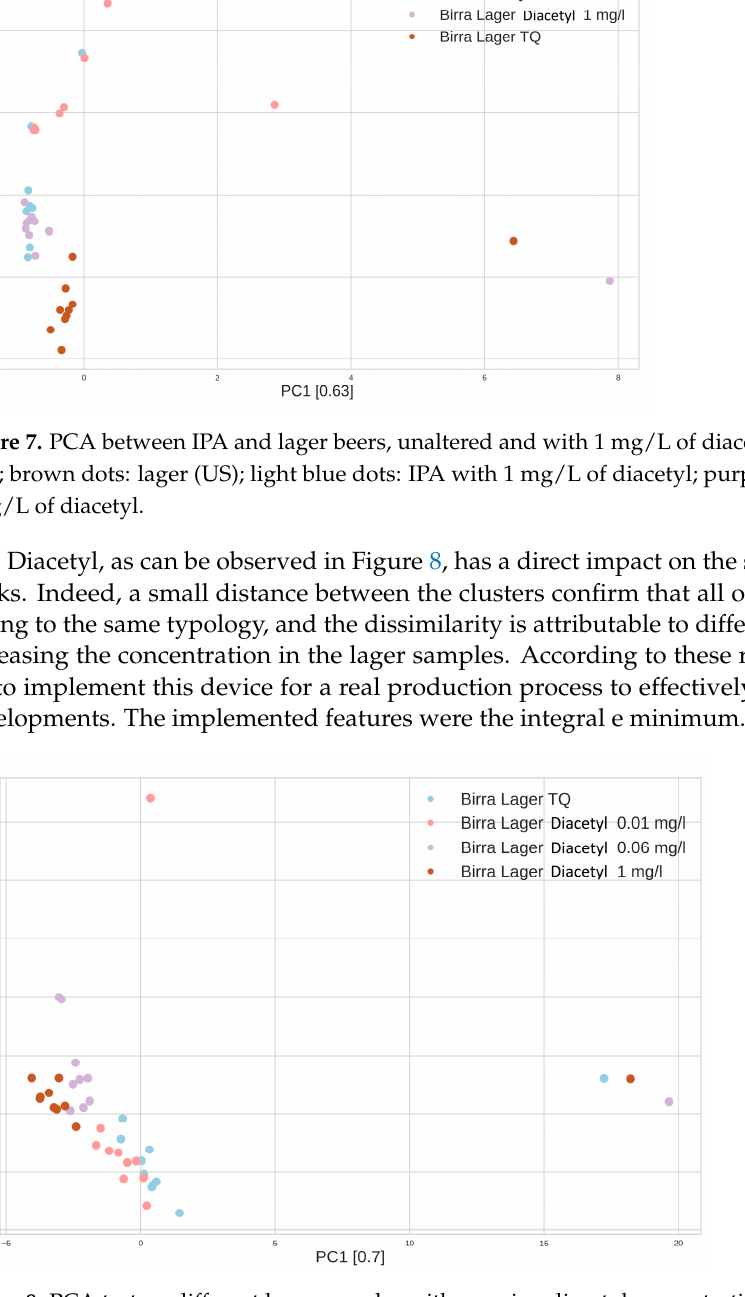
Figure 8. PCA test on different lager samples with growing diacetyl concentration. Light blue dots: lager (US); pink dots: lager 0.01 mg/L; purple dots: lager 0.06 mg/L; brown dots: lager 1 mg/L.